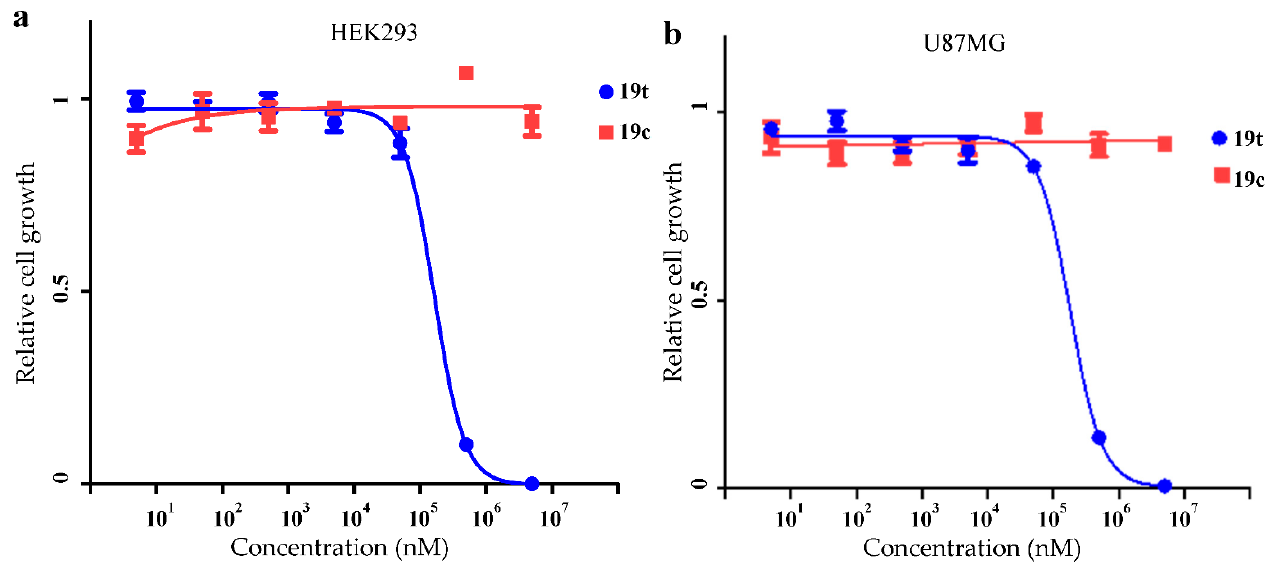
Figure 3. Cytotoxicity of compounds against HEK293 ( a ) and U87MG cells ( b ). All data were obtained by three independent experiments, and the cell viability values were normalized to vehicle control. All data are expressed as mean ± SEM.